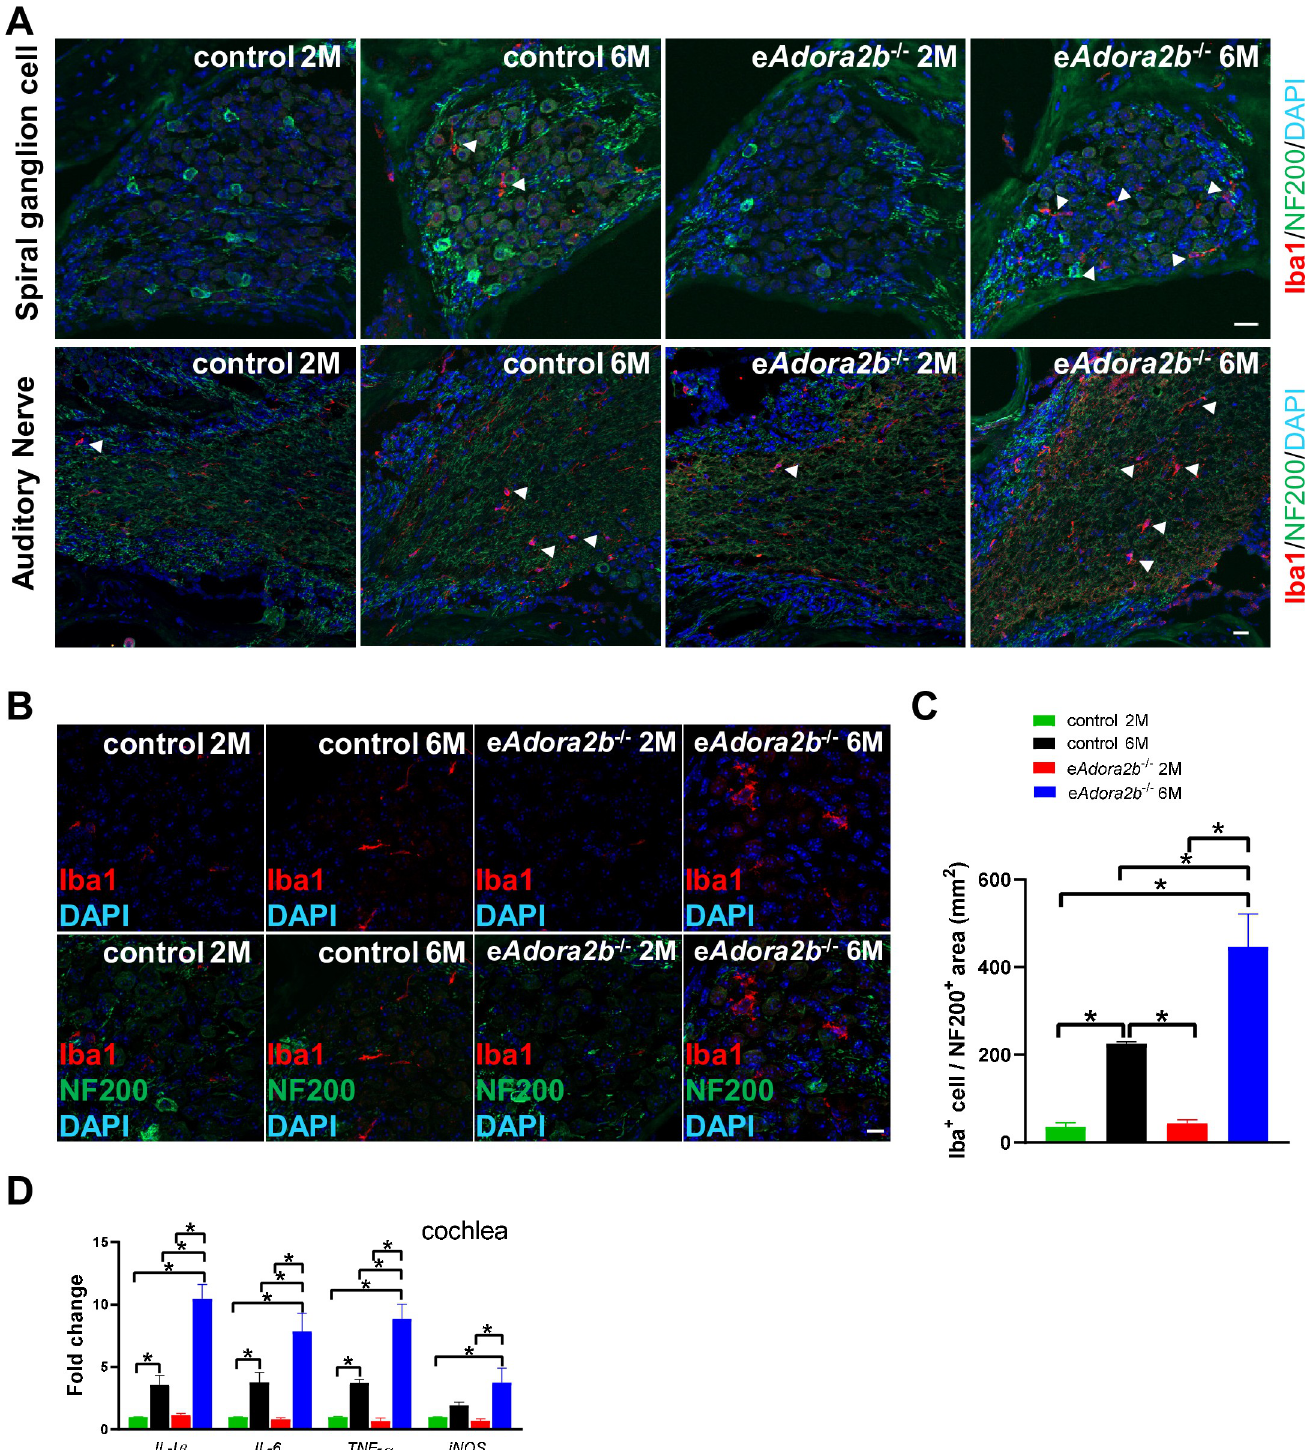
Fig 3. Increased abundance of enlarged macrophages and pro-inflammatory cytokines in cochlea of e Adora2b − / − mice at 6 months old. (A) Representative images of macrophages around spiral ganglion cells and AN were identified by Iba1 and NF200 staining. Scale bar, 20 μ m. Arrowheads indicate macrophage cells. (B) Representative high-magnification images show morphology of macrophages in RC. Scale bar, 10 μ m. (C) Macrophage cells in RC were counted from apex to basal in 2 slices for each mouse. Data are expressed as mean ± SEM. n = 3 mice/group. � P < 0.05. (D) Pro-inflammatory cytokine mRNA expression levels in cochlea were measured by qRT-PCR, which were normalized to β -actin mRNA. Data are expressed as mean ± SEM. n = 4–5 mice/group, � P < 0.05. � P were